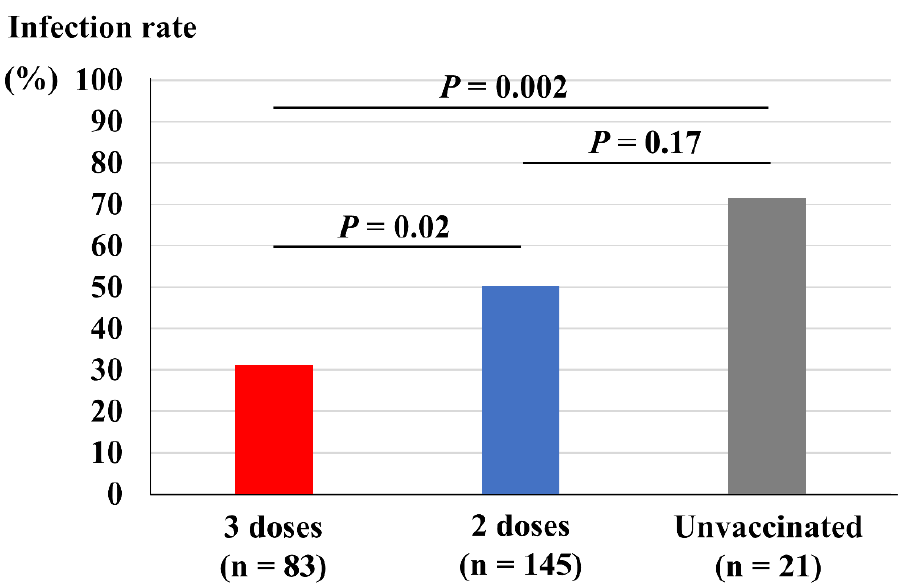
Figure 2. Vaccine doses and infection rate among the close